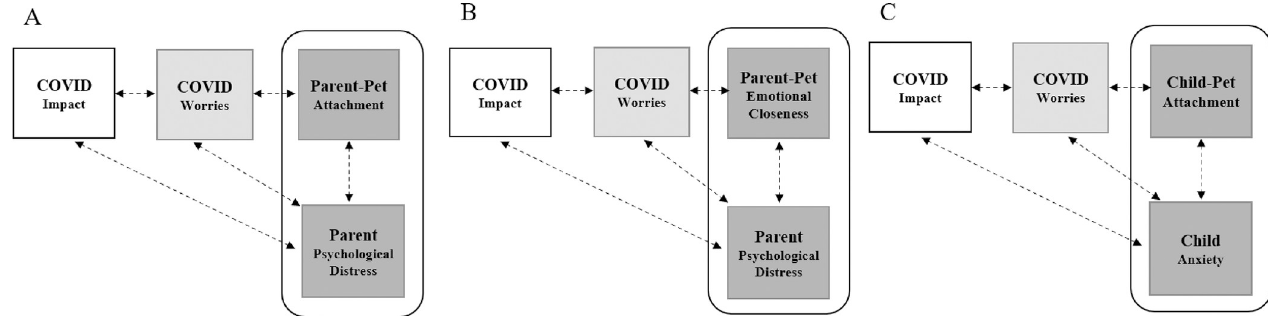
Fig 1. Models to be tested: (A) Parent-pet attachment, (B) Parent-pet emotional closeness, (C) Child-pet attachment.